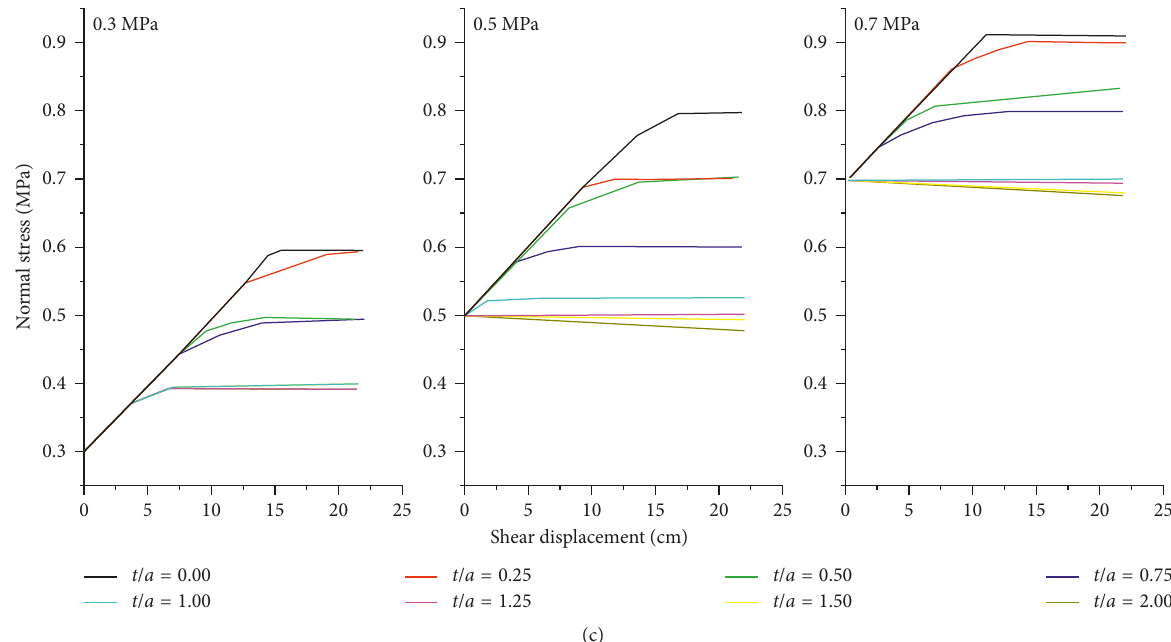
Figure 8: Shearing characteristics curve of the infilled joint with different infilled ratios t / a . (a) Shear stress-shear displacement curve. (b) Normal displacement-shear displacement curve. (c) Normal stress-shear displacement